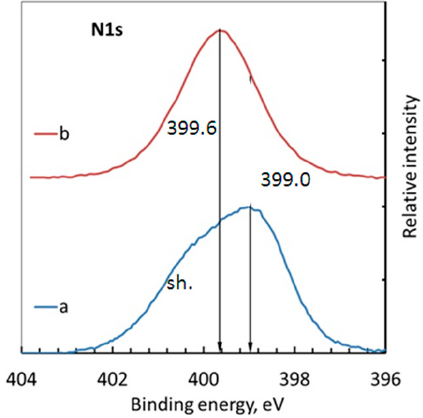
Figure 3. X-ray photoelectron spectroscopy (XPS) of N1s electrons. a: MPATA powder; b: on the surface of brass after 17 h immersion in the buffer solution with 0.01 mM MPATA.